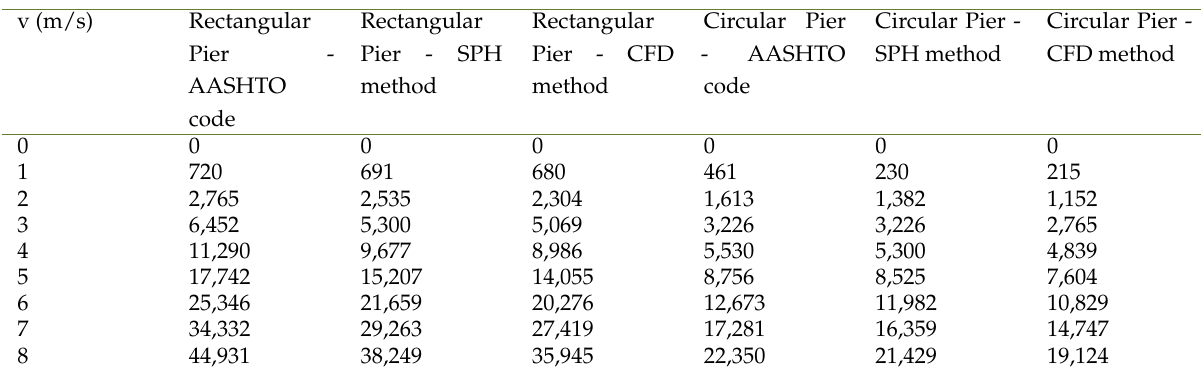
Table 1. Fluid pressures computed by SPH model, CFD method and AASHTO LRFD for rectangular and circular piers (units: